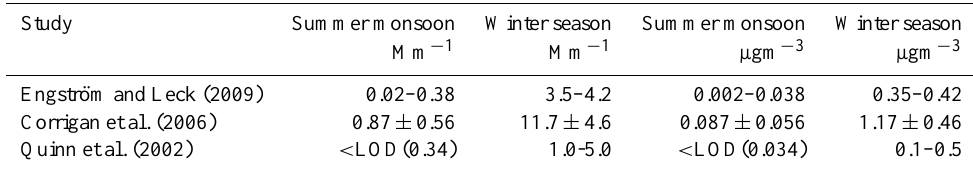
Table 5. Absorption coefficient values in air measured with optical techniques in the Indian Ocean region. BC mass concentrations were derived using a mass absorption cross-section of 10 ± 1m 2 g − 1